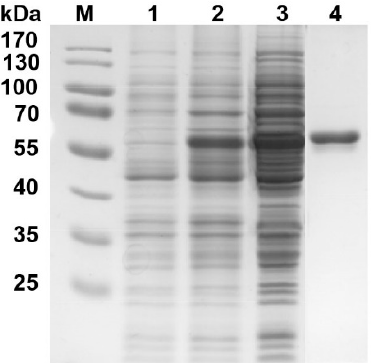
Figure 4. SDS-PAGE electrophoretic analysis of the 4CL3 recombinant protein of ramie. (M) protein marker; (1) total protein from strains with empty vector after IPTG (Isopropyl β -D-Thiogalactoside) induction; (2) total protein from treatment strains after IPTG induction; (3) protein in supernatant from treatment after IPTG induction; and (4) purified recombinant 4CL3 protein.